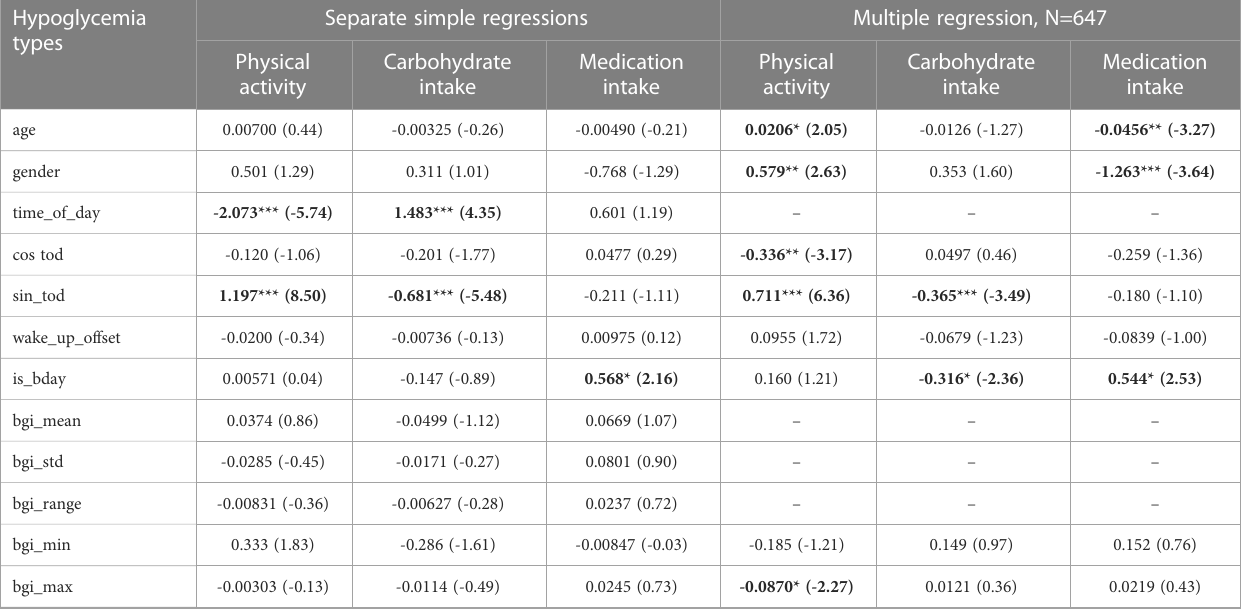
TABLE 2 Regression